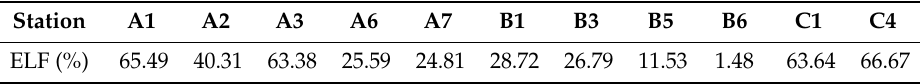
Figure 4. Microscopic observations of in situ response of phytoplankton. Fresh phytoplankton samples were treated with enzyme-labelled fluorescence (ELF) reagent for extracellular phosphatase detection. Green fluorescence ELF-labelling associated with cells was observed. ( a–c ) Trichodesmium sp. from transects A, B, and C. ( d–f ) Prorocentrum sp., Ceratium sp. and Coscinodiscus sp. from transaction D. Scale bars indicate 10 µ m. Table 2. Elf-labeling cells of the sampling stations in the southern